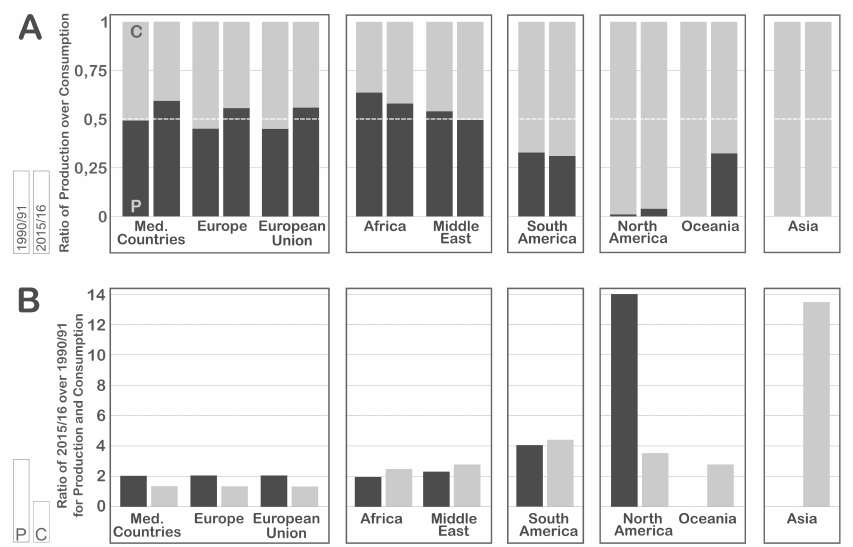
Figure 1: Dynamics of production and consumption by world regions. (A) Relative weight of production over consumption in 1990/91 and 2015/16 and (B) relative growth in 2015/16 over 1990/91 of production and consumption Neves, Pires 2013) where spacing between trees (an average of 100 trees per hectare) allows a second crop or pastoralism to be part of a biodiverse landscape (Avraamides, Fatta 2008, European Commission 2012, Ferreira